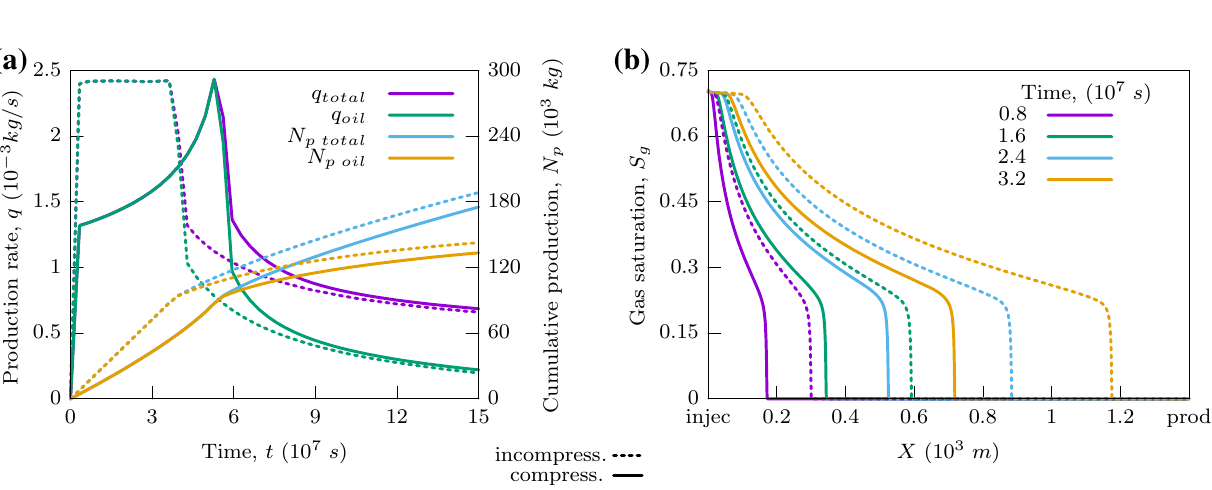
nd not graphically depicted calculations, but their results are